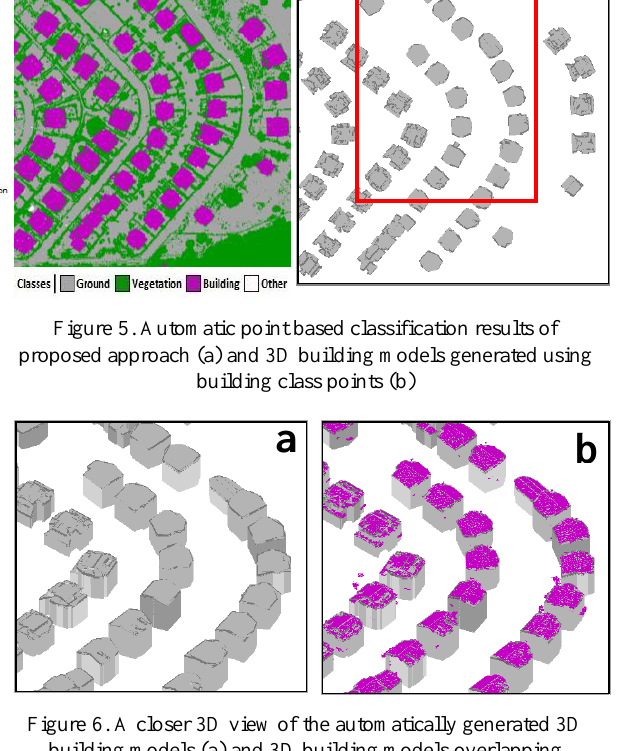
Figure 6. A closer 3D view of the automatically generated 3D building models (a) and 3D building models overlapping building class points obtained using proposed approach